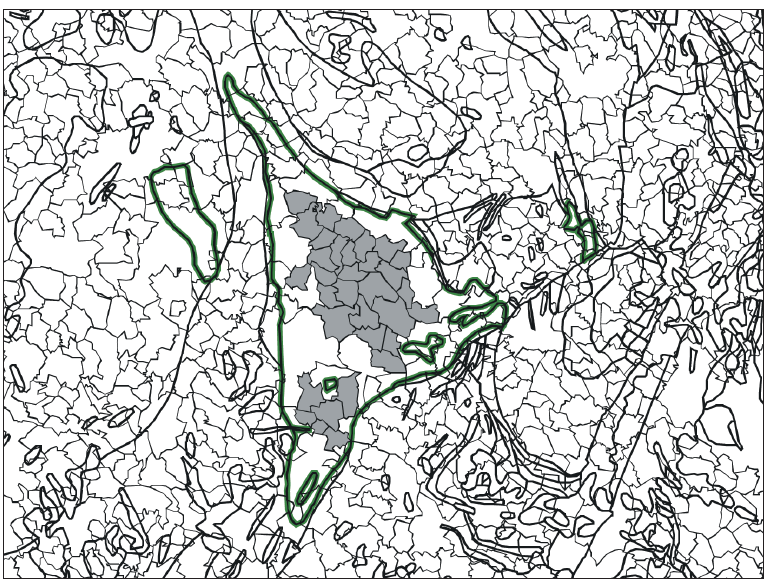
Fig. 2. The selection of cadastres based on placing the polygons of cadastres inside contours of durbachite bod- ies (bold outlined) without